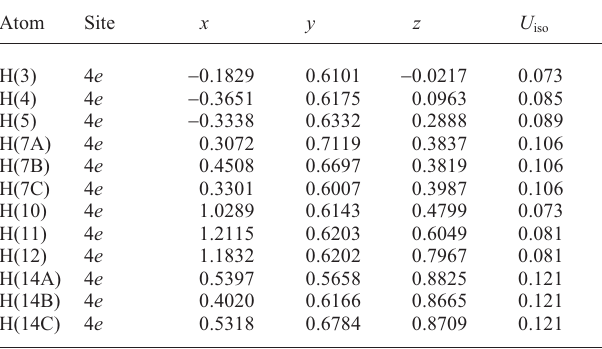
Table 2. Atomic coordinates and displacement parameters (in Å 2 )